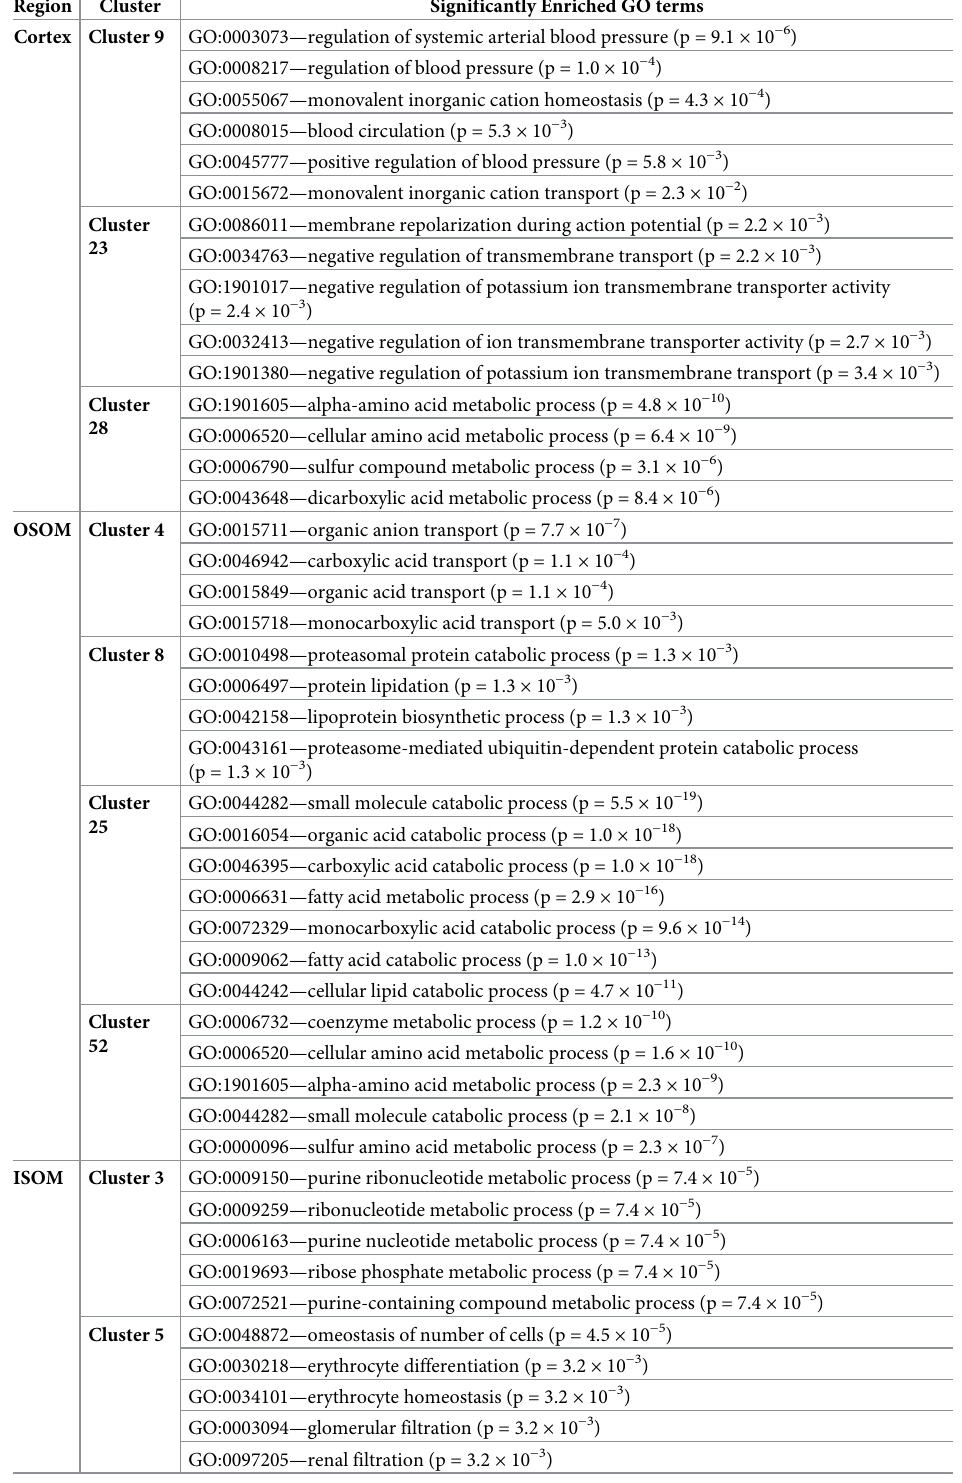
Table 3. Functional terms enriched by spatial gene clusters (most significantly relevant